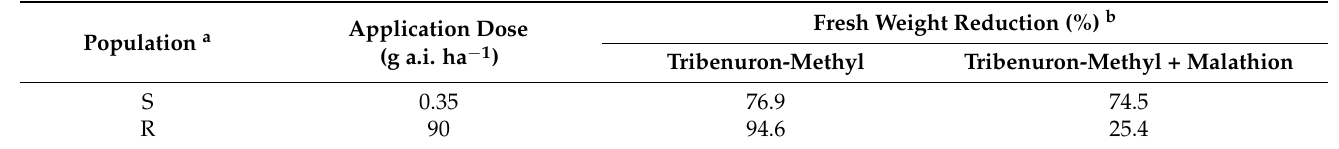
Table 3. Fresh weight control rate of susceptible (S) and resistant (R) populations of Silene conoidea in response to tribenuron-methyl with or without malathion